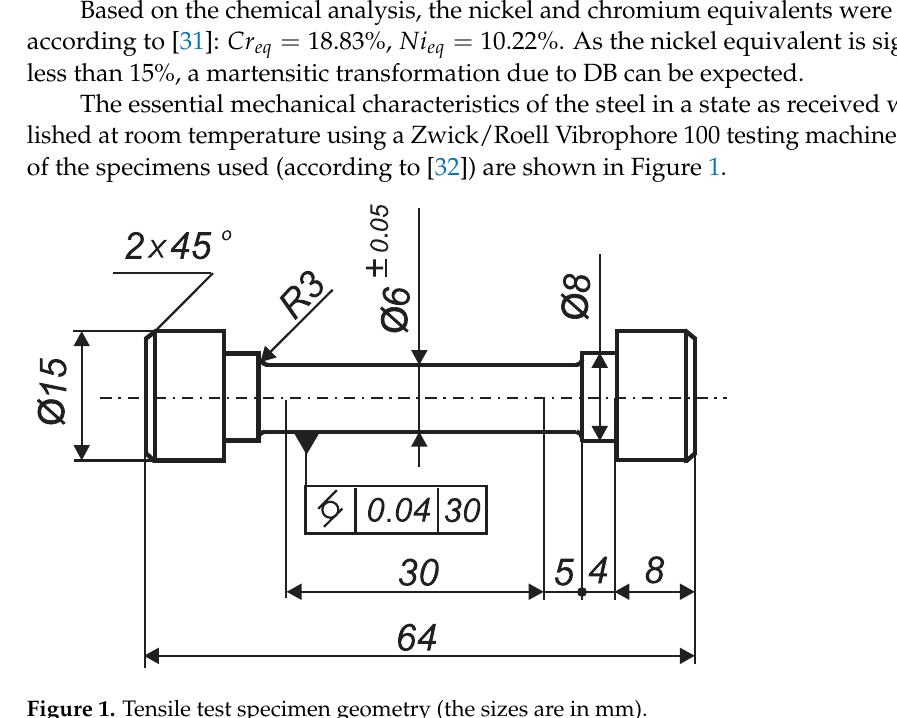
Figure 1. Tensile test specimen geometry (the sizes are in mm).